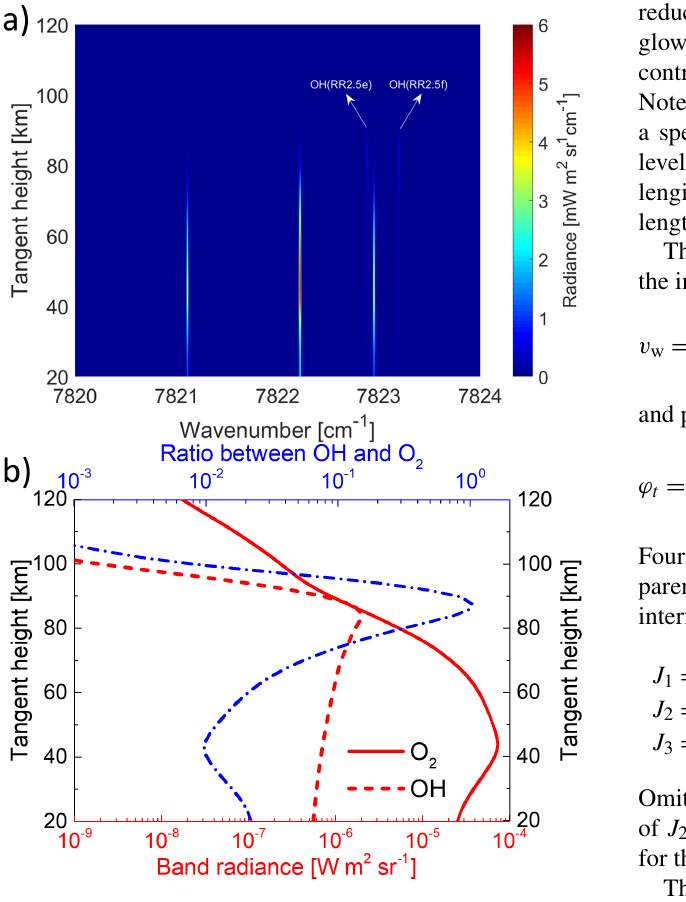
Figure 3. The total spectral irradiance and band radiance as a func- tion of tangent height. (a) The total spectral irradiance containing O 2 ( a 1 (cid:49) g ) and OH dayglow as a function of tangent height. (b) The band radiance profiles of the O 2 ( a 1 (cid:49) g ) and OH dayglow and their